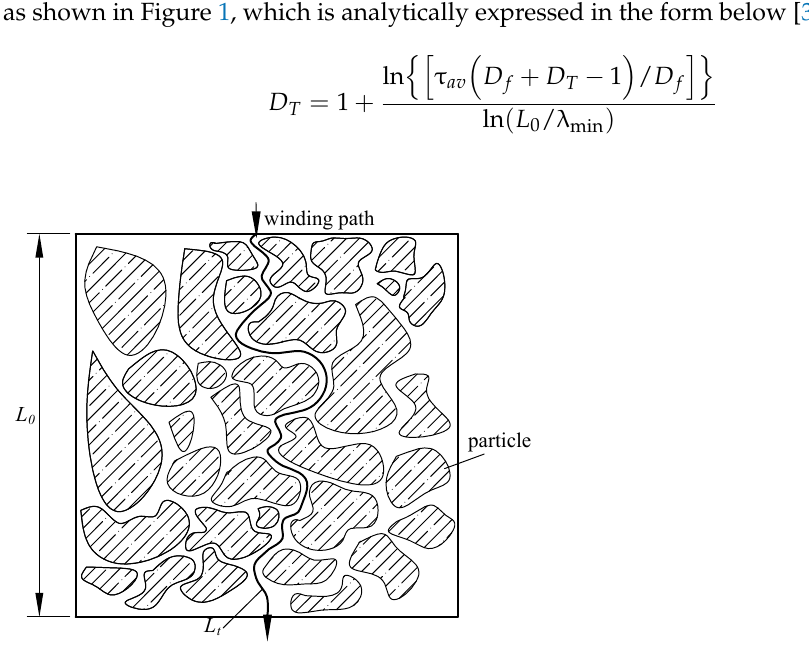
Figure 1. The winding paths in the porous